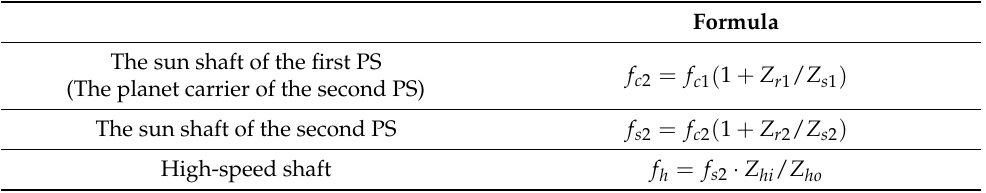
Table 4. Rotational frequencies of different shafts in the gearbox with two planetary stages and one parallel